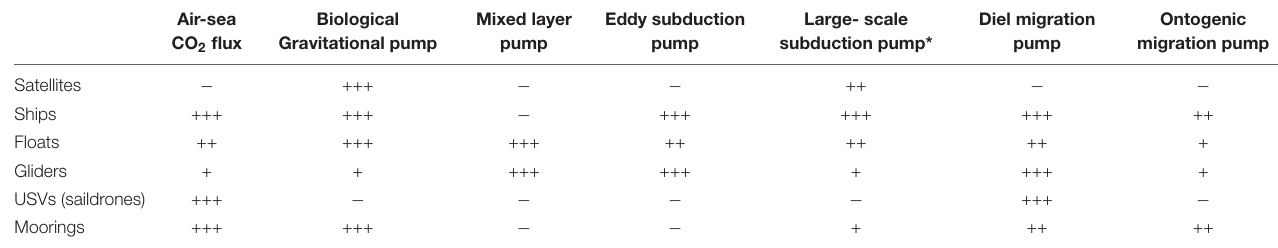
TABLE 3 | Potential contributions of the different observation platforms to the creation of a multiplatform strategy to investigate the air-sea CO 2 flux and the six